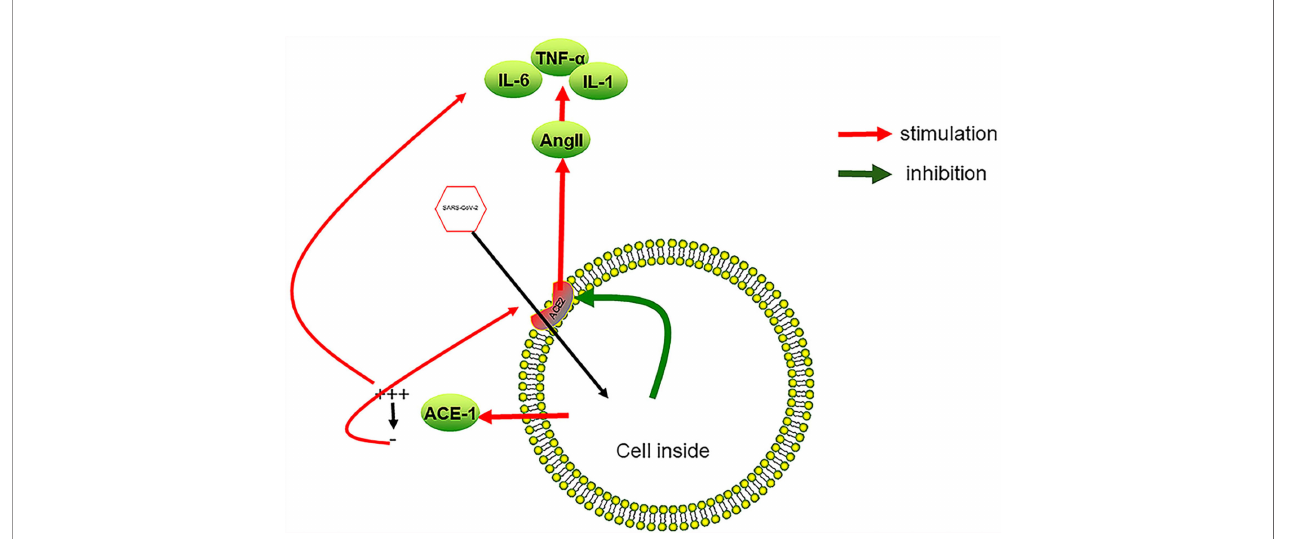
FIGURE 3 | SARS-CoV-2 infection causes in fl ammation of vascular endothelial cells. After SARS-CoV-2 enters endothelial cells from ACE2, it promotes the reduction of ACE2 on the cell surface, which in turn leads to an increase in AngII in the blood, a decrease in local anti-in fl ammatory ability, and an increase in the expression of cytokines such as TNF- a , IL-6, and IL-1. Overexpression of in fl ammatory factors leads to the damage of vascular endothelial cells and the formation of a local procoagulant state. On the other hand, SARS-CoV-2 causes ACE1 to fall off the cell surface at the initial stage of infection, which promotes local plasma leakage and the expression of in fl ammatory factors. As the free ACE1 drops to a very low level, ACE2 is induced, which, in turn, promotes SARS-CoV-2 to enter endothelial cells. A vicious cycle between SARS-CoV-2 infection and overexpression of in fl ammatory factors